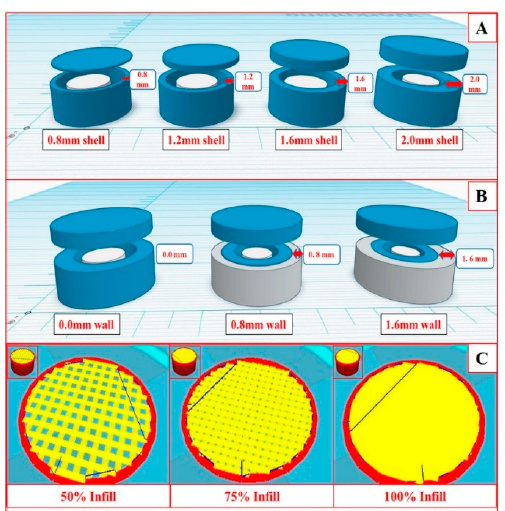
Figure 2. Graphical images of the floating tablets with different shell thickness ( A ), wall thickness ( B ), and infill density ( C ).